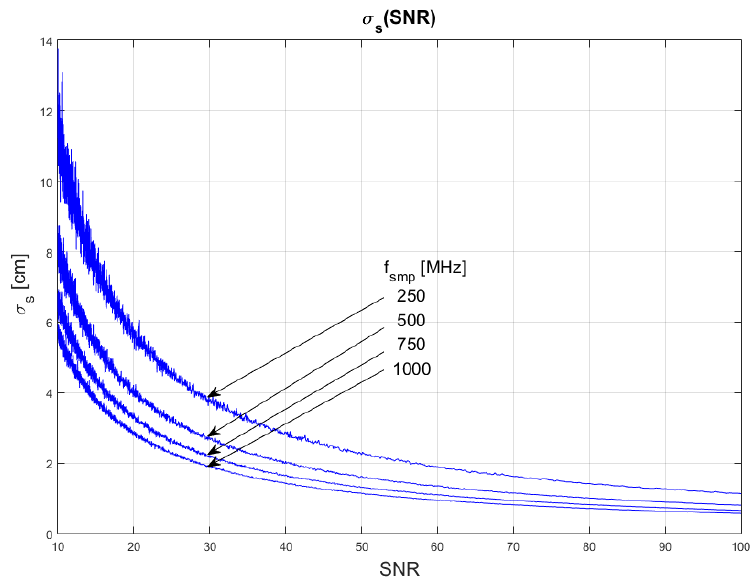
Figure 5. Dependence of measurement uncertainty on the signal-to-noise ratio (SNR). Parameters of generated pulses are shown in Table 1 Block 2.